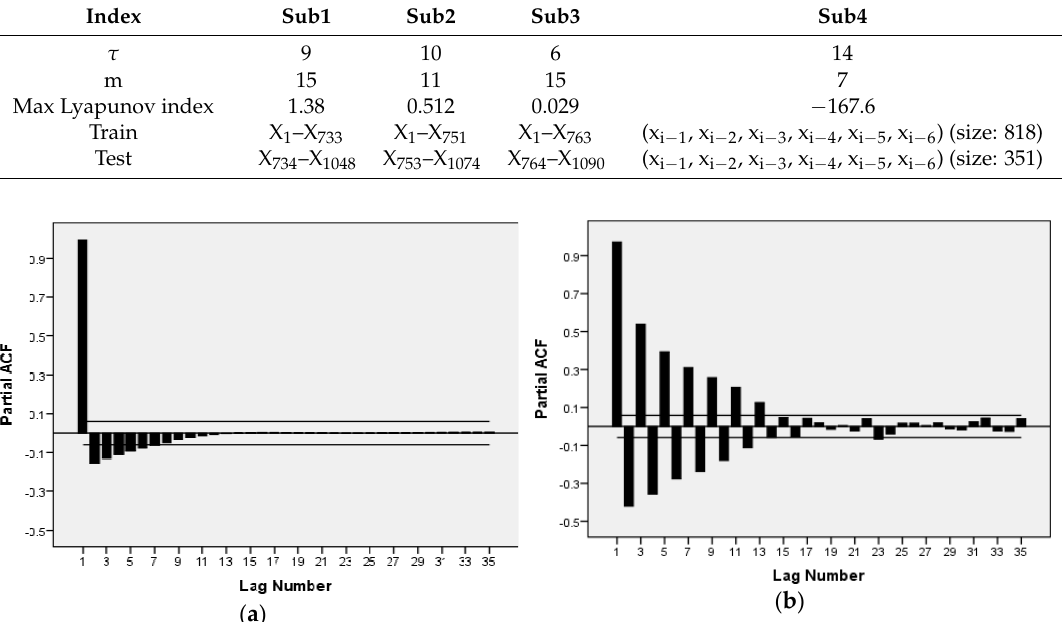
Figure 9. ( a ) The result of the PACF analysis of sub4 after processing by EMD of the Beijing carbon price; ( b ) The result of the PACF analysis of A1 after processing by WT of the Beijing carbon price. Table 6. The parameters of the approximation subsequences decomposed by wavelet transform (WT).